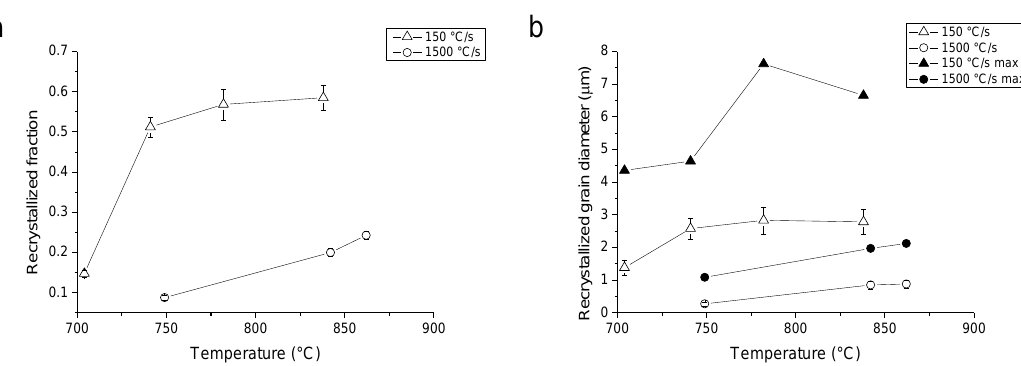
Figure 2. ( a ) Fraction of recrystallized ferrite and ( b ) average ferritic grain size (outlined) and maximum ferritic grain size (filled) versus annealing temperature. In both plots, triangles and circles represent samples annealed with 150 °C/s and 1500 °C/s respectively. The average grain diameter of recrystallized ferrite in samples heated at 150 °C/s (cf. outlined